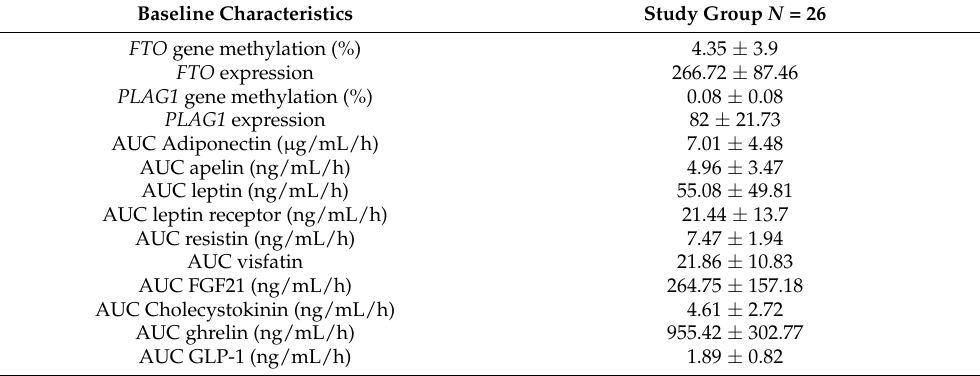
Table 3. The metabolic parameters of the study group. Values are presented as mean ± standard deviation.